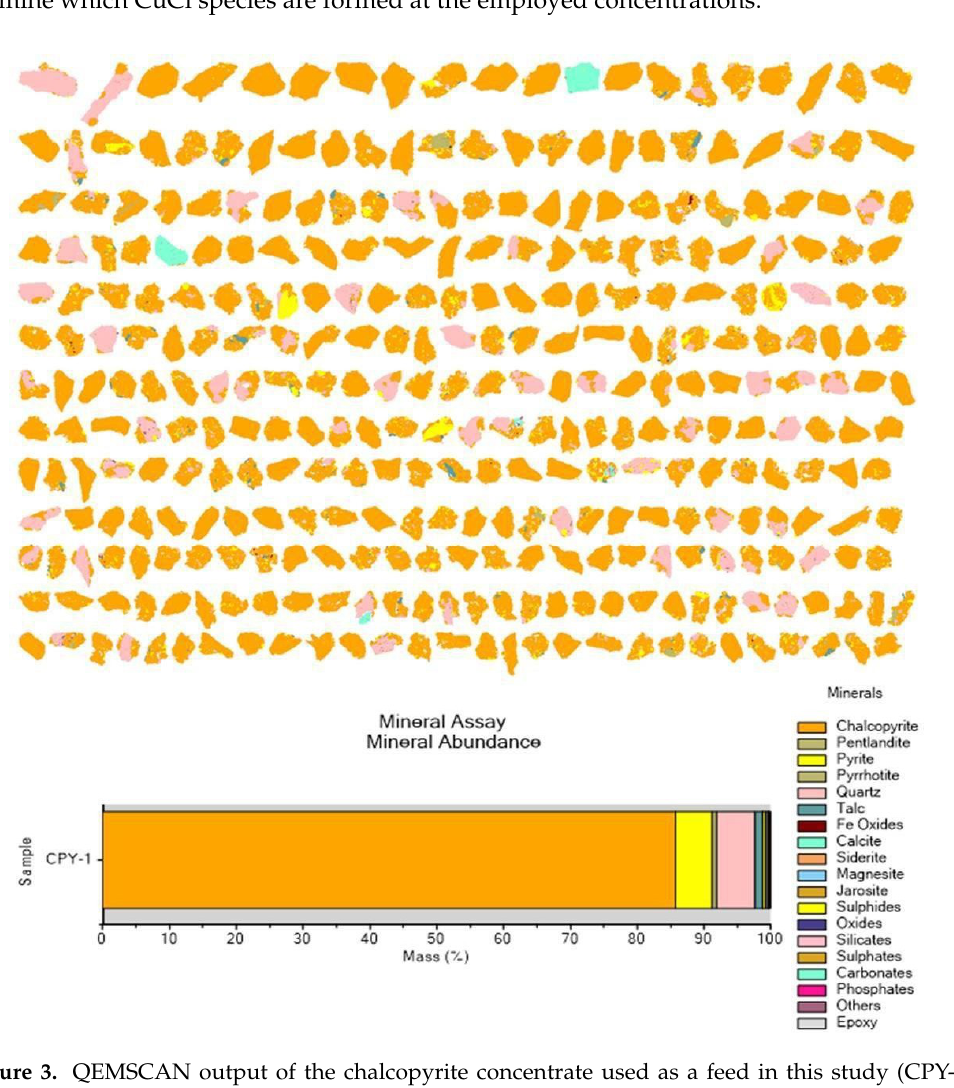
Figure 3. QEMSCAN output of the chalcopyrite concentrate used as a feed in this study (CPY-1 corresponds to the identity of the feed sample).